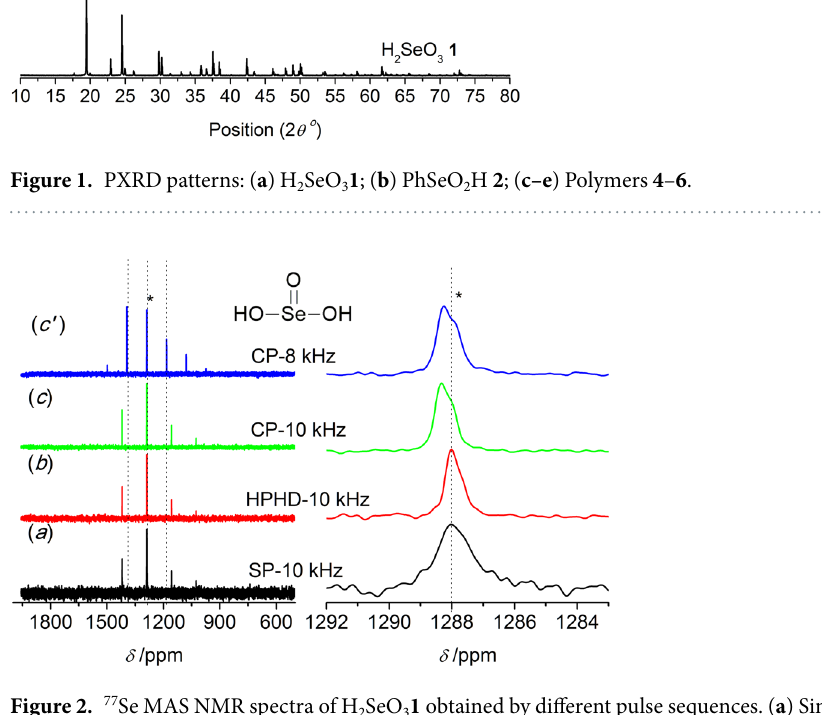
Figure 2. 77 Se MAS NMR spectra of H 2 SeO 3 1 obtained by different pulse sequences. ( a ) Single pulse (SP); ( b ) High power 1 H decoupling (HPHD); ( c, c ′ ) Cross polarization (CP), 16 scans and the spinning speed of 10 kHz or 8 kHz. The isotropic peak is labeled with an asterisk ( *